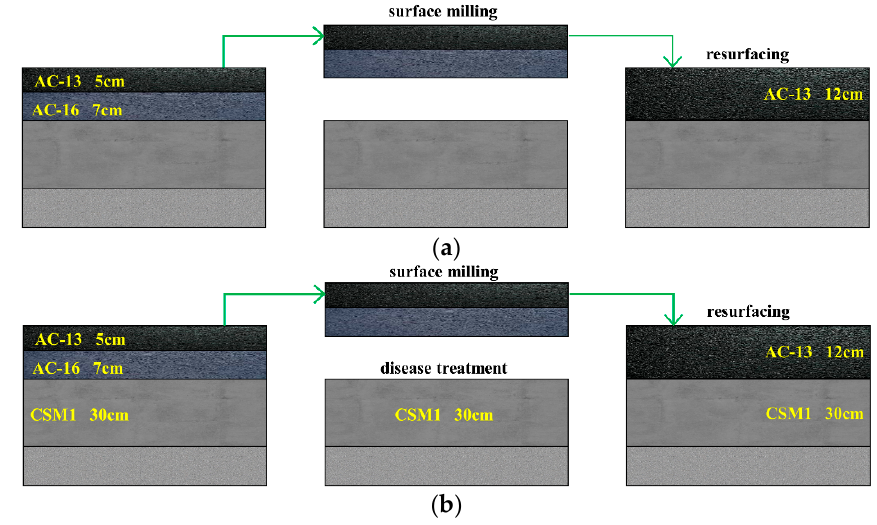
Figure 11. ( a ) The first maintenance measure and ( b ) the second maintenance